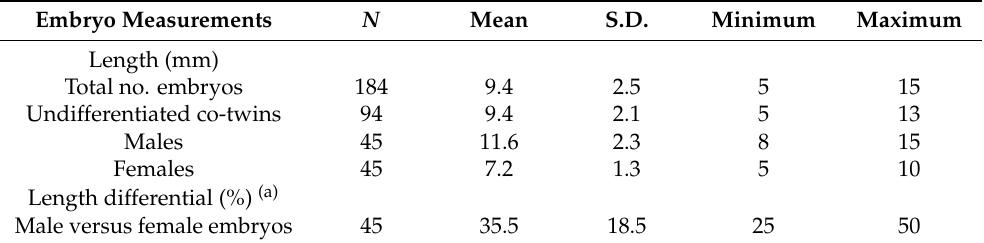
Table 2. Mean, standard deviation (S.D.), minimum, and maximum values of measurements for the total number of embryos and sexed embryos recorded from days 28 to 34 of gestation ( n = 92 twin embryo pairs).